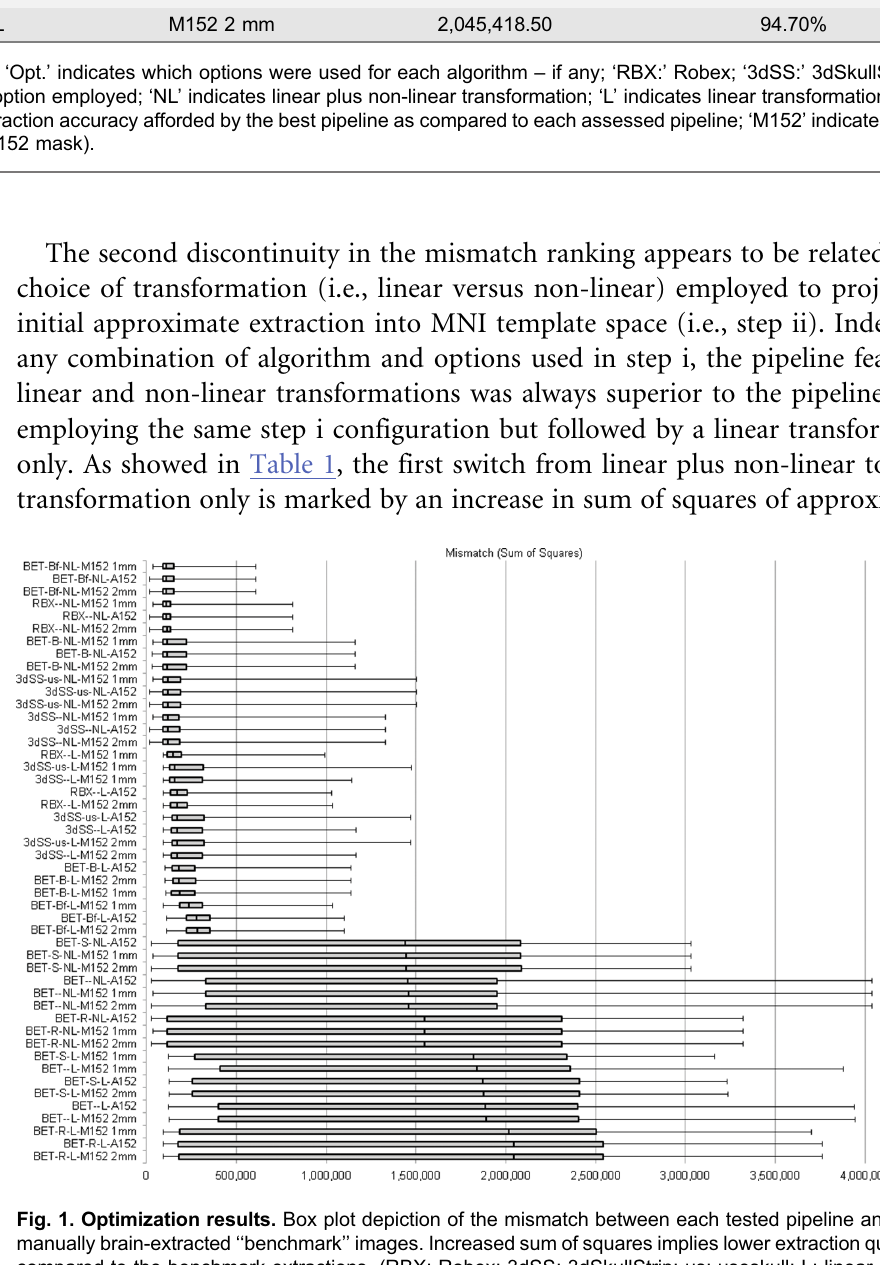
Fig. 1. Optimization results. Box plot depiction of the mismatch between each tested pipeline and the manually brain-extracted ‘‘benchmark’’ images. Increased sum of squares implies lower extraction quality – as compared to the benchmark extractions. (RBX: Robex; 3dSS: 3dSkullStrip; us: useskull; L: linear transformation; NL: non-linear transformation; M152: MNI152; A152: Average152. The boxplot depicts the 25 th , 50 th (i.e., median) and 75 th percentiles, and top and bottom whiskers depict the maximum and minimum values,